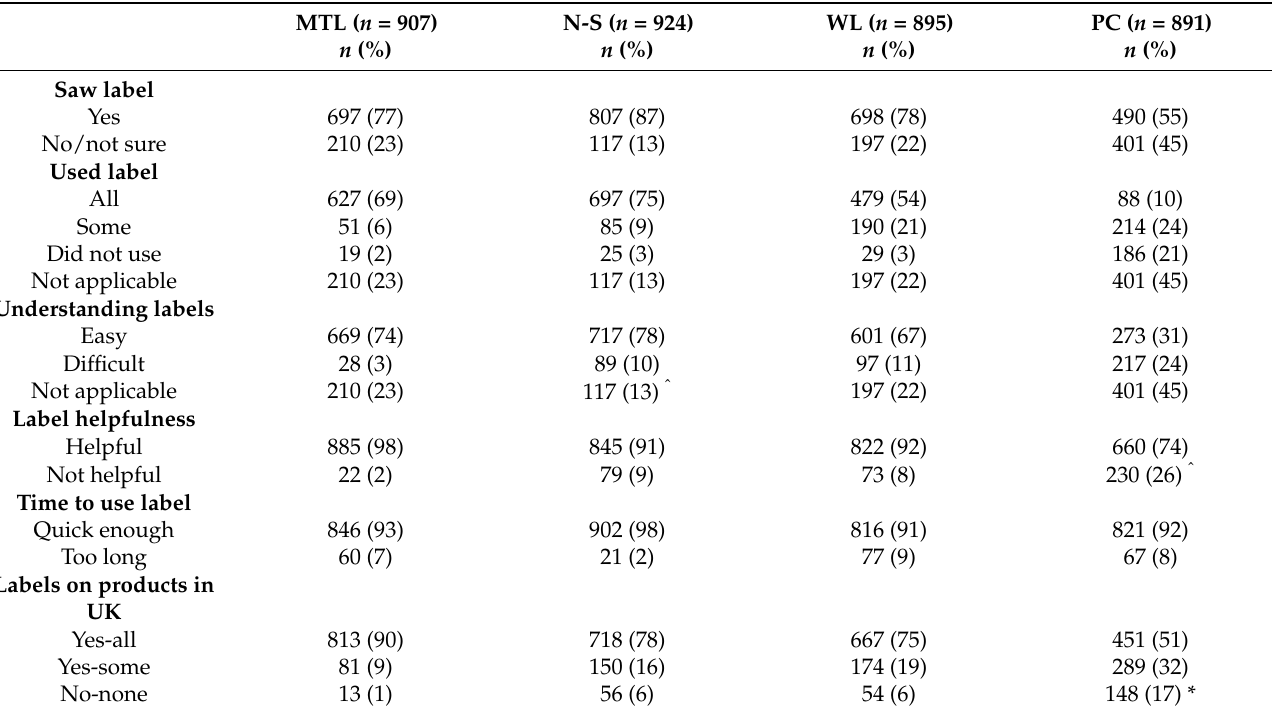
Table 6. Proportions of participant FOPL perception outcomes, by FOPL group.